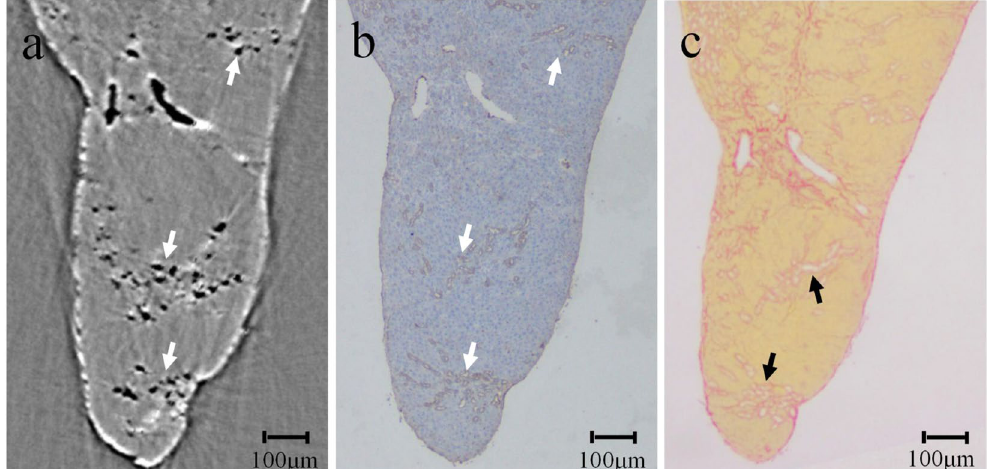
Figure 2. CT image and corresponding pathological sections of the BDL rats. In the immunohistochemical staining for CK19 ( b ), CK19-expressing cells appear to form larger clusters that are stained brown, which is in accordance with the CT findings ( a ), which are marked by the white arrows. In the histological slice stained with Sirius Red ( c ), fibrous bands are clearly shown within the regions marked by black